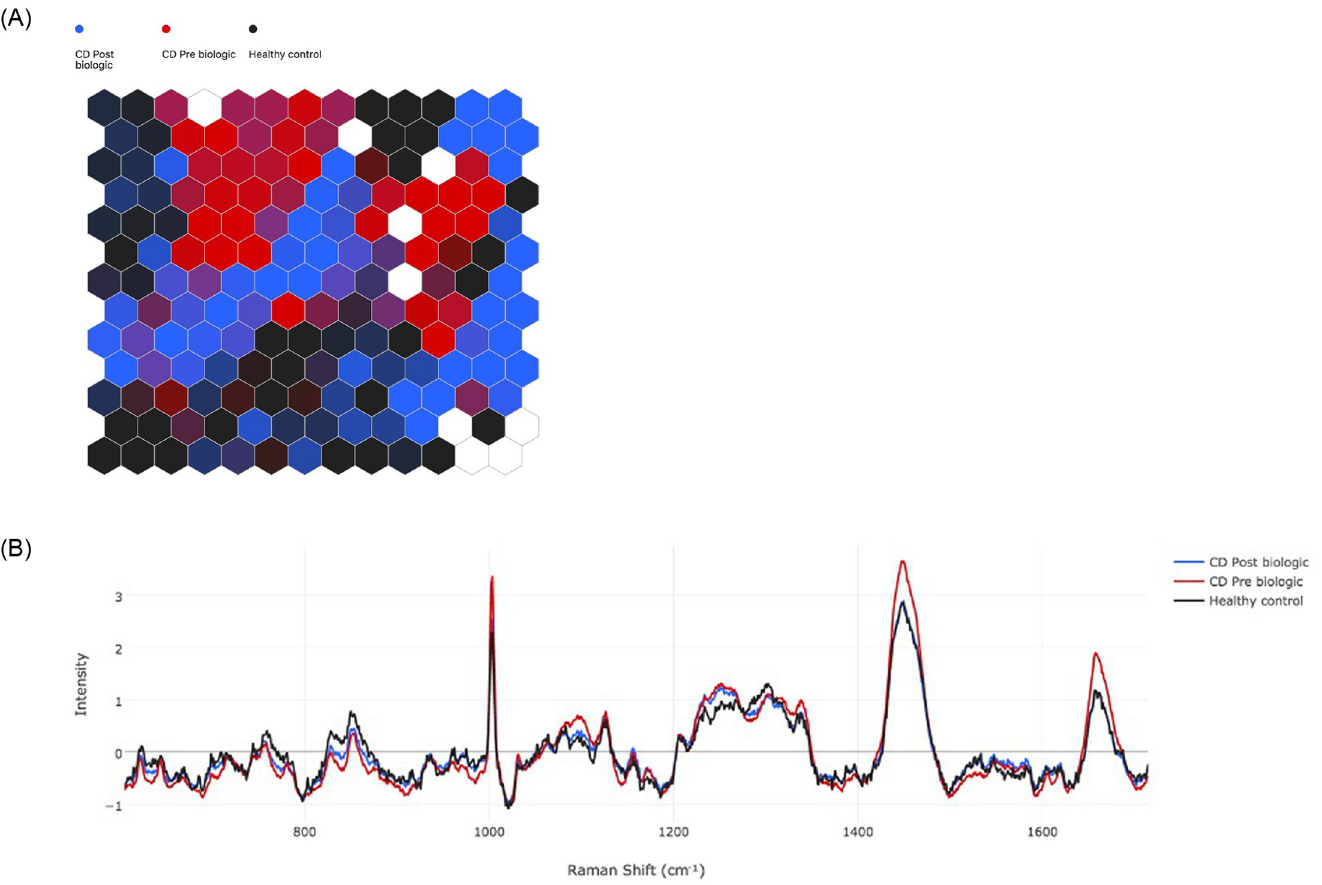
Fig 6. CD pre- (red) vs. post-biologic therapy (blue) vs. healthy control (black). a) Self-organising Map (SOM) demonstrates the groupings and b) Self-organising Map Discriminant Index (SOMDI) highlights the spectral differences from the SOM.